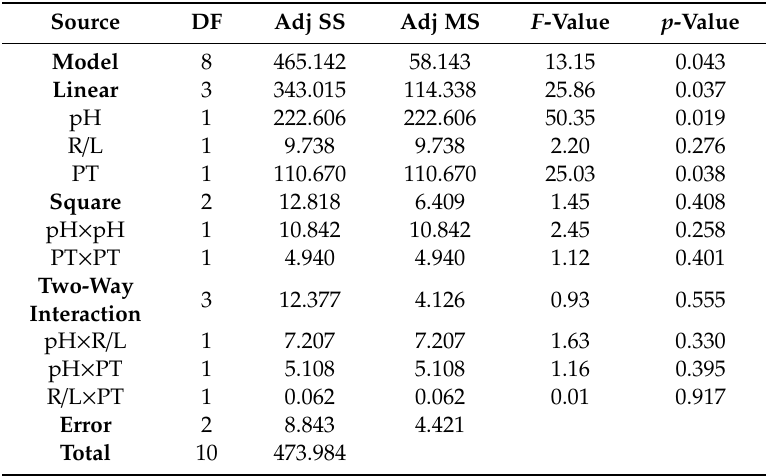
Table 2. ANOVA table of RSM represented a model for the final